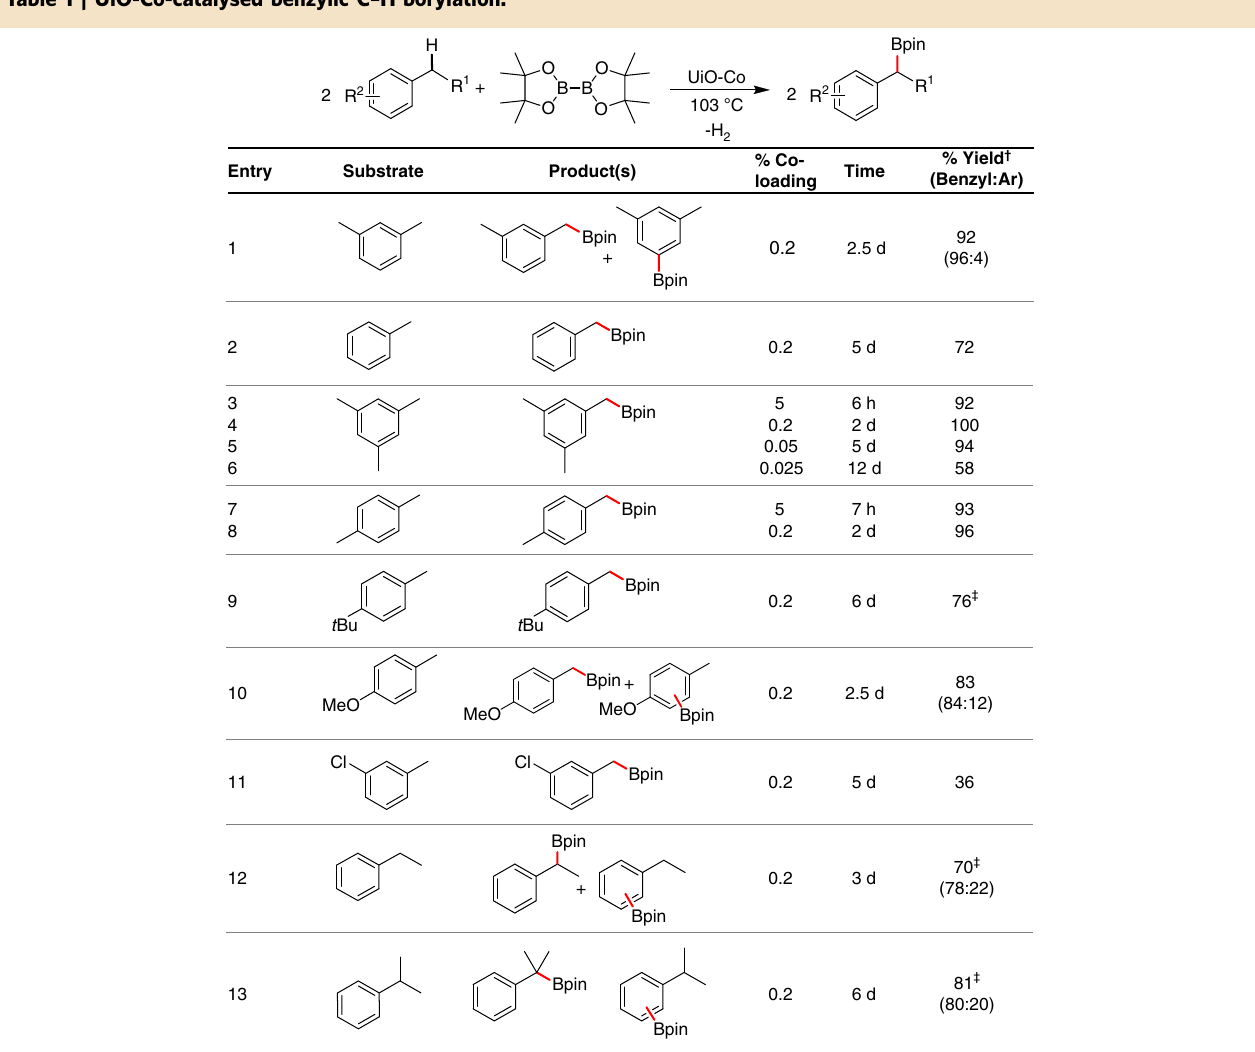
Table 1 | UiO-Co-catalysed benzylic C–H